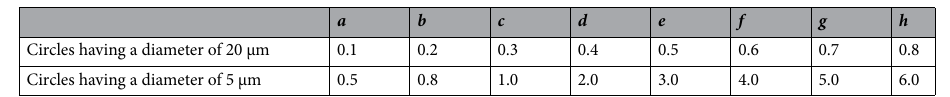
Table 2. Electron densities set for circles of 20 and 5 µm diameter of the phantom. Values are the difference (+ %) between the electron density of water.